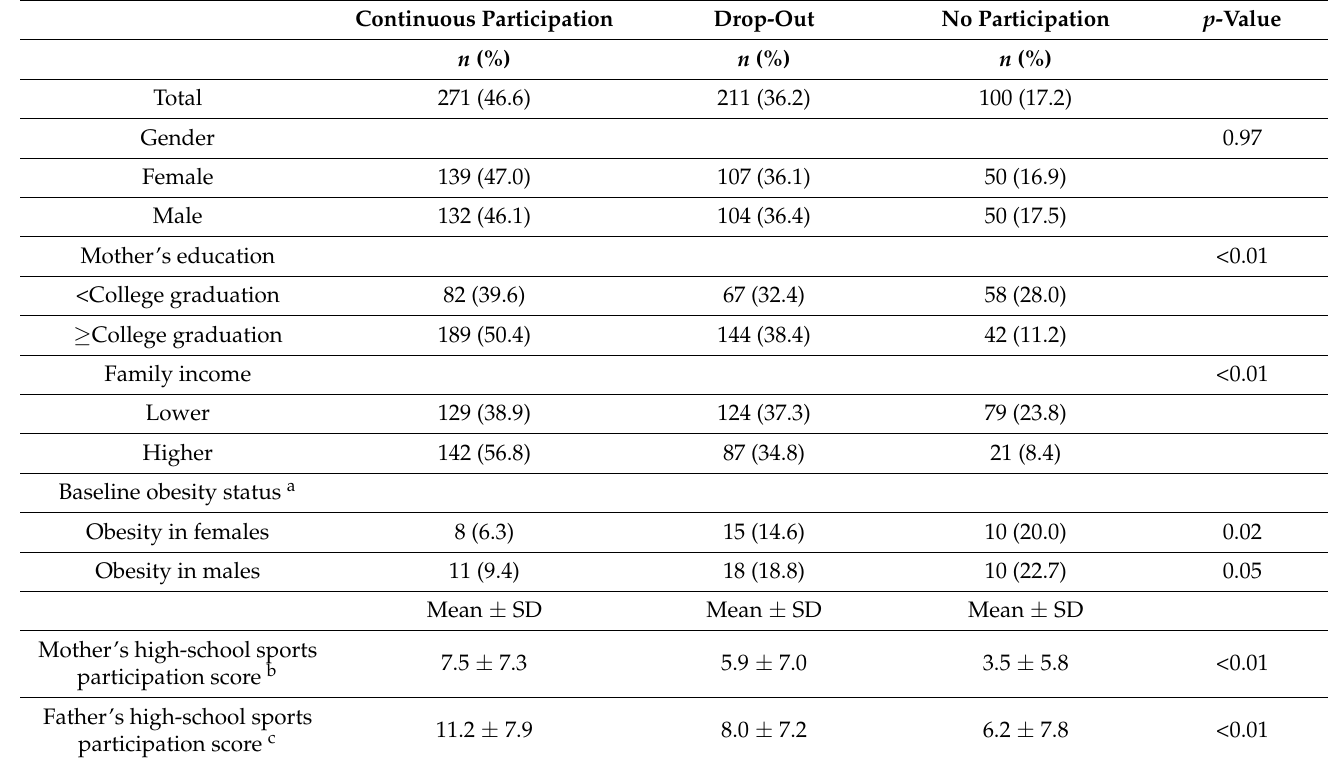
Table 1. Participant characteristics by youth sports participation patterns ( n = 582).